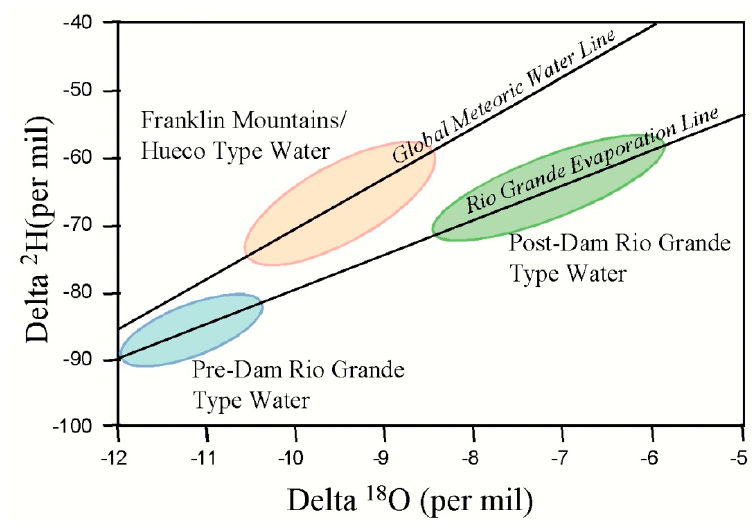
Figure 4. Major regional water types in the Hueco Bolson and stable water isotopes plotted for alluvial and bolson water wells sampled in this study. Regional water types include local recharge waters that characterize the Franklin Mountains/Hueco-type water and pre-dam and post-dam Rio Grande